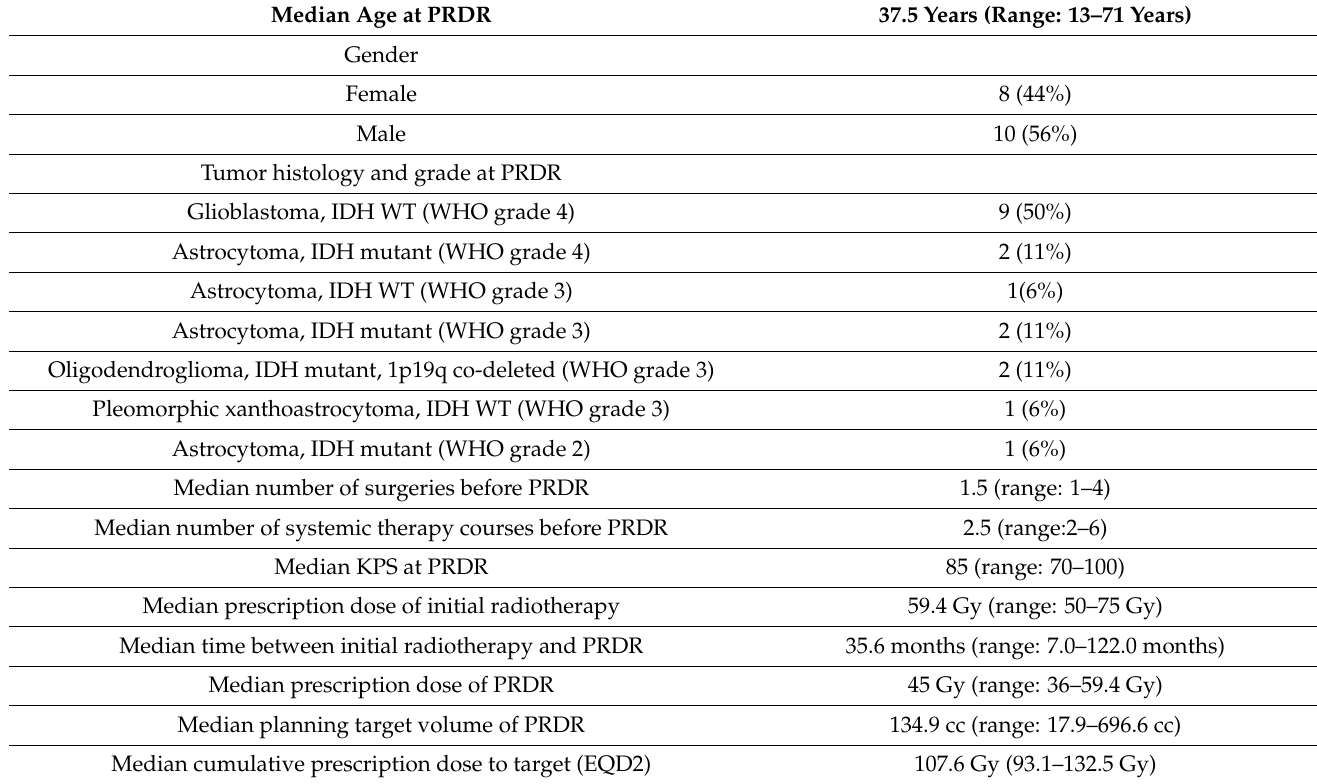
Table 1. Patient, disease, and treatment